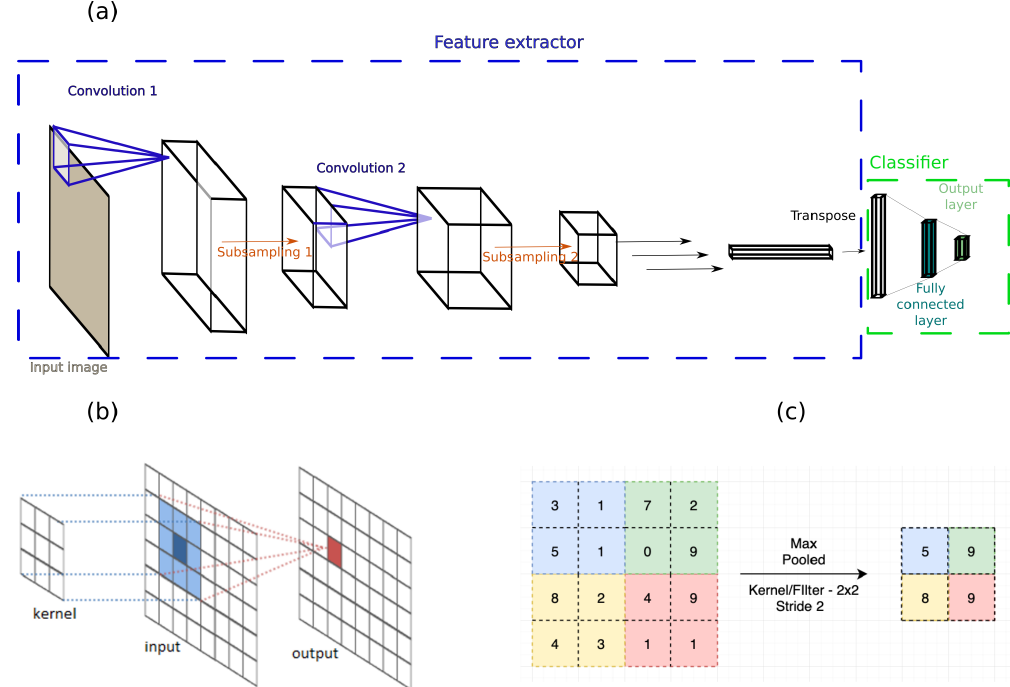
Figure 2. CNN architecture and building blocks. (a) Simplified architecture of convolutional neural networks. (b) Elementary operation at the heart of convolutions from http://intellabs.github.io/RiverTrail/tutorial/ (last access: 7 September 2022). (c) Illustration of maxPooling, found at https://medium.com/mlearning-ai/images-from-the-convolutional-world-596b4aa6cdae (last access: 7 September